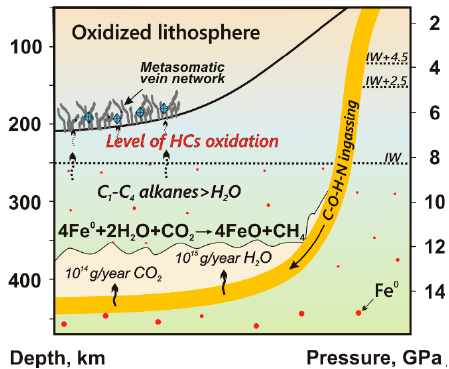
Figure 7. Formation of light alkanes in the zone of interaction between slab-derived oxidized volatiles and Fe 0 -bearing mantle. Black arrows show paths and relative magnitudes of volatile fluxes [29,31]. IW (Fe–FeO buffer), IW + 2.5 log units, and IW + 4.5 log units are f O 2 values according to [13]. Metasomatic vein network is according to [68]. Blue rhombs are mark diamonds.